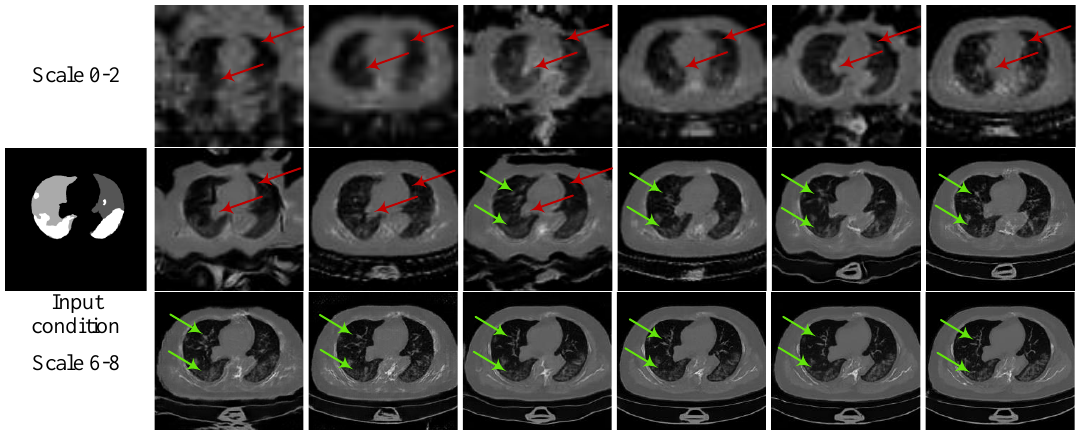
Figure 9. Illustration of the synthesized images with all nine scales from CoSinGAN. Each scale consists of two synthesized images, where one is from the first stage and the other one is from the second stage. All images are resized to 512 × 512 for better visualization. The white and gray (e.g., light gray and dark gray) in condition masks represent the infected regions and lungs, respectively. Red arrows are used to track the contour of the lungs and green arrows are used to track the details of the lungs and infected